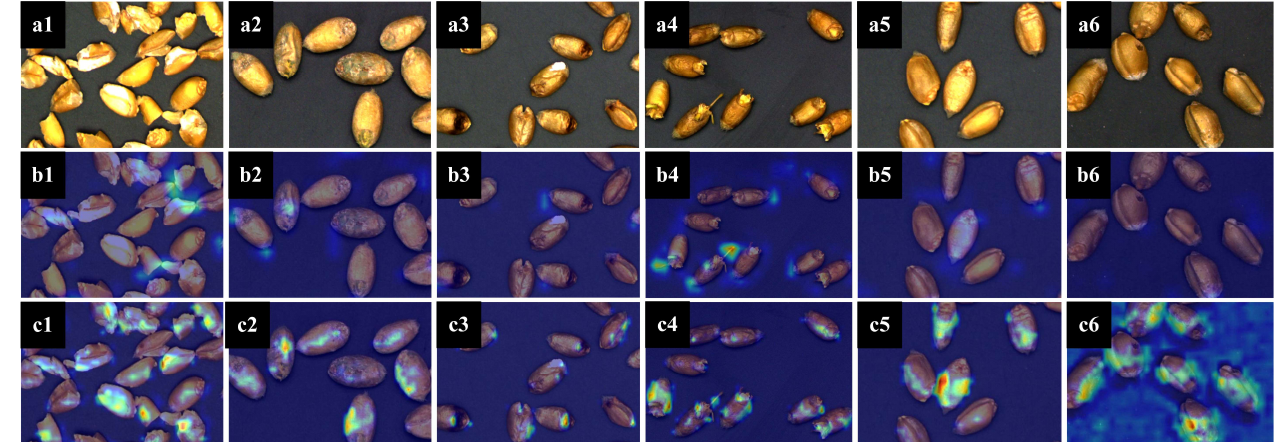
Figure 4. Heat-MAP of unsound kernels and perfect kernels. ( a1 ) Original image of broken kernels. ( a2 ) Original image of moldy kernels. ( a3 ) Original image of spotted kernels. ( a4 ) Original image of sprouted kernels. ( a5 ) Original image of perfect kernels. ( a6 ) Original image of injured kernels. ( b1 ) Mask RCNN heat-MAP of broken kernels. ( b2 ) Mask RCNN heat-MAP of moldy kernels. ( b3 ) Mask RCNN heat-MAP of spotted kernels. ( b4 ) Mask RCNN heat-MAP of sprouted kernels. ( b5 ) Mask RCNN heat-MAP of perfect kernels. ( b6 ) Mask RCNN heat-MAP of injured kernels. ( c1 ) Improved mask RCNN heat-MAP of broken kernels. ( c2 ) Improved mask RCNN heat-MAP of moldy kernels. ( c3 ) Improved mask RCNN heat-MAP of spotted kernels. ( c4 ) Improved mask RCNN heat-MAP of sprouted kernels. ( c5 ) Improved mask RCNN heat-MAP of perfect kernels. ( c6 ) Improved Mask RCNN heat-MAP of injured kernels.